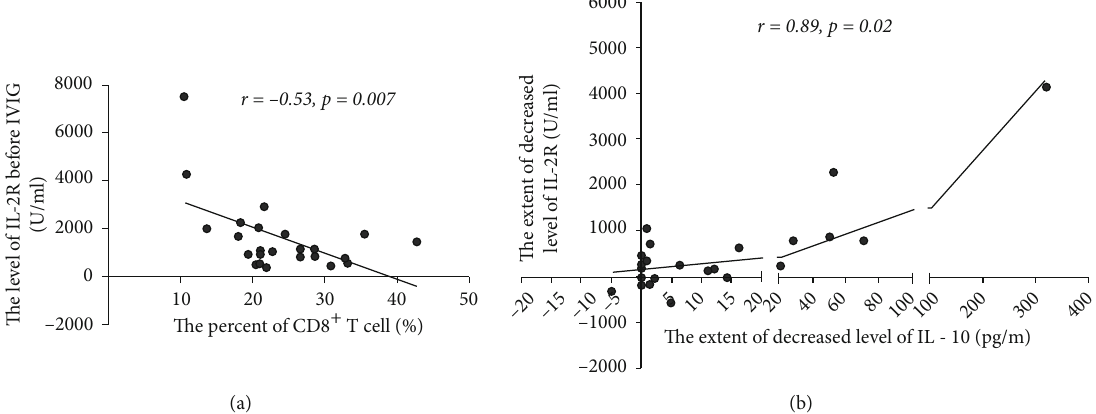
Figure 2: In children with KD who were ≥ 4 years old, there was a close correlation between the levels of IL-2R and the percentage of CD8 + T cells and the level of IL-10. (a) The levels of IL-2R before IVIG in children with KD who were ≥ 4 years old were negatively correlated with the percentage of CD8 + T cells. (b) The extent of the decrease of the levels of IL-2R was positively correlated with the extent of the decrease of the levels of